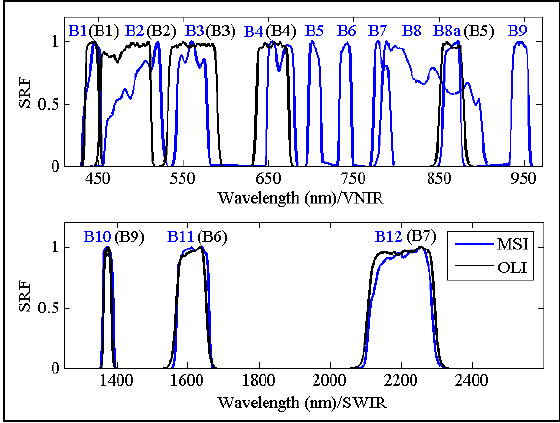
Figure 1. Spectral response functions (SRFs) of Sentinel-2A MSI channels (blue line) and Landsat 8 OLI (black line) over the visible and near infrared (VNIR) regions (up) and the short- wave infrared (SWIR) regions (below).